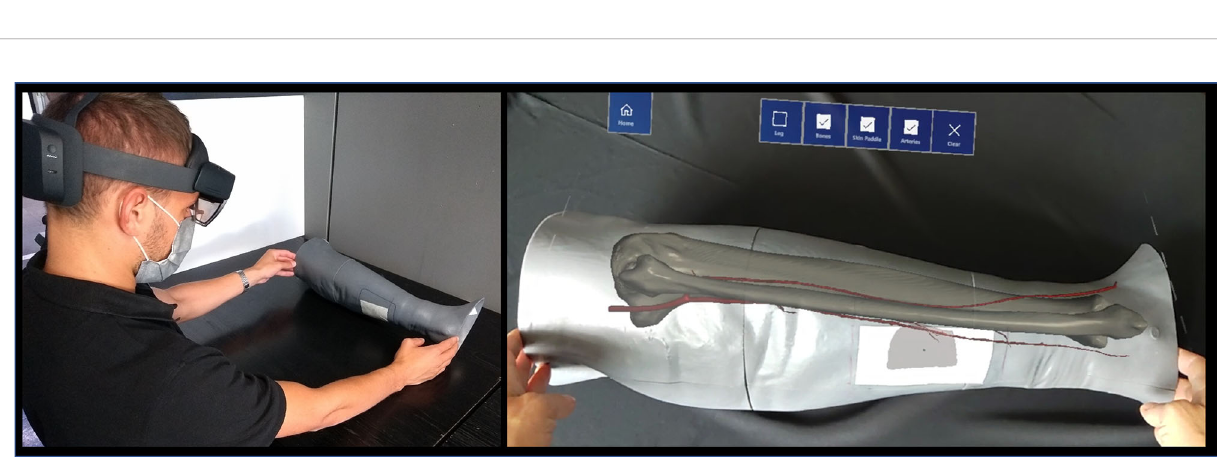
FIGURE 5 | The AR application generating the holographic overlays superimposed on the real phantom anatomy, as displayed to surgeon via HoloLens 2 smart